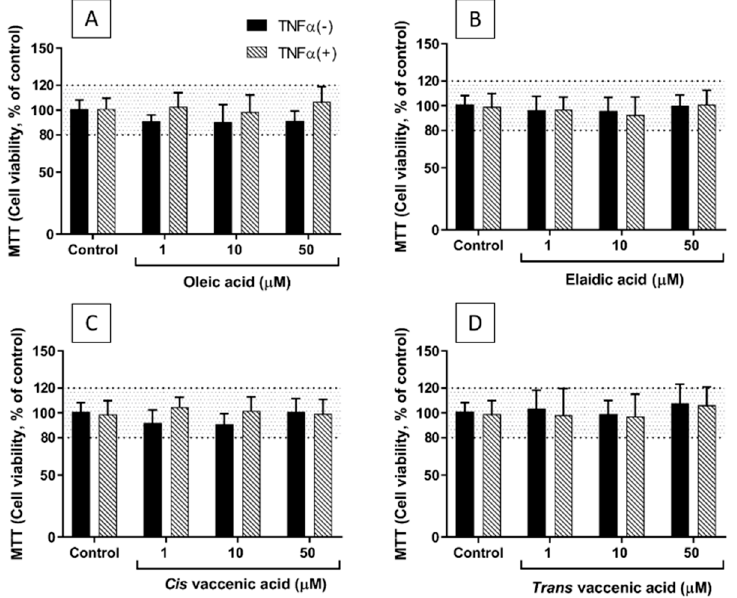
Figure 1. Viability of EA.hy926 cells after preincubation for 48 h with supplemented DMEM con- taining 0.1% of ethanol (Control) or different concentrations (1, 10, and 50 μ M) of oleic acid ( A ), elaidic acid ( B ), cis vaccenic acid ( C ), or trans vaccenic acid ( D ), followed by incubation with (+) or without ( − ) TNF- α (1 ng/mL) for 24 h. Bars are mean ± SEM of 9 samples performed in 3 experiments. Data were analysed using two-way ANOVA with Tukey’s post hoc test. There were no significant effects observed.